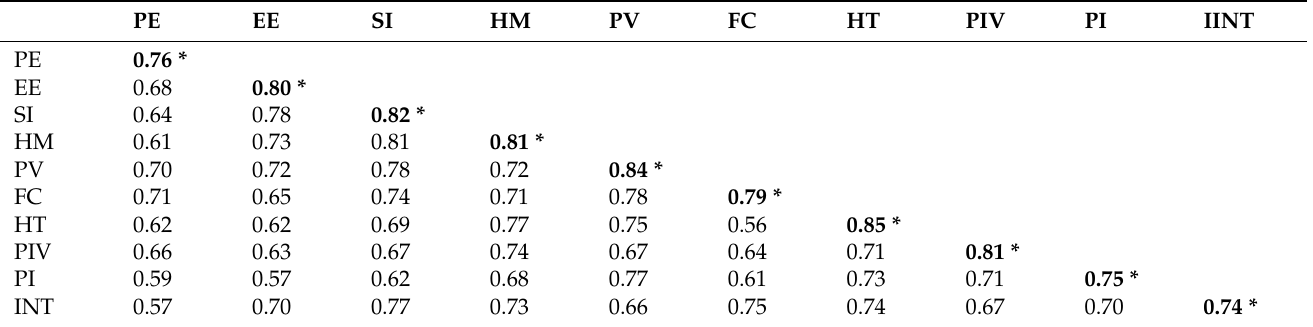
Table 2. Correlations between constructs (diagonal elements are square roots of average variance extracted).